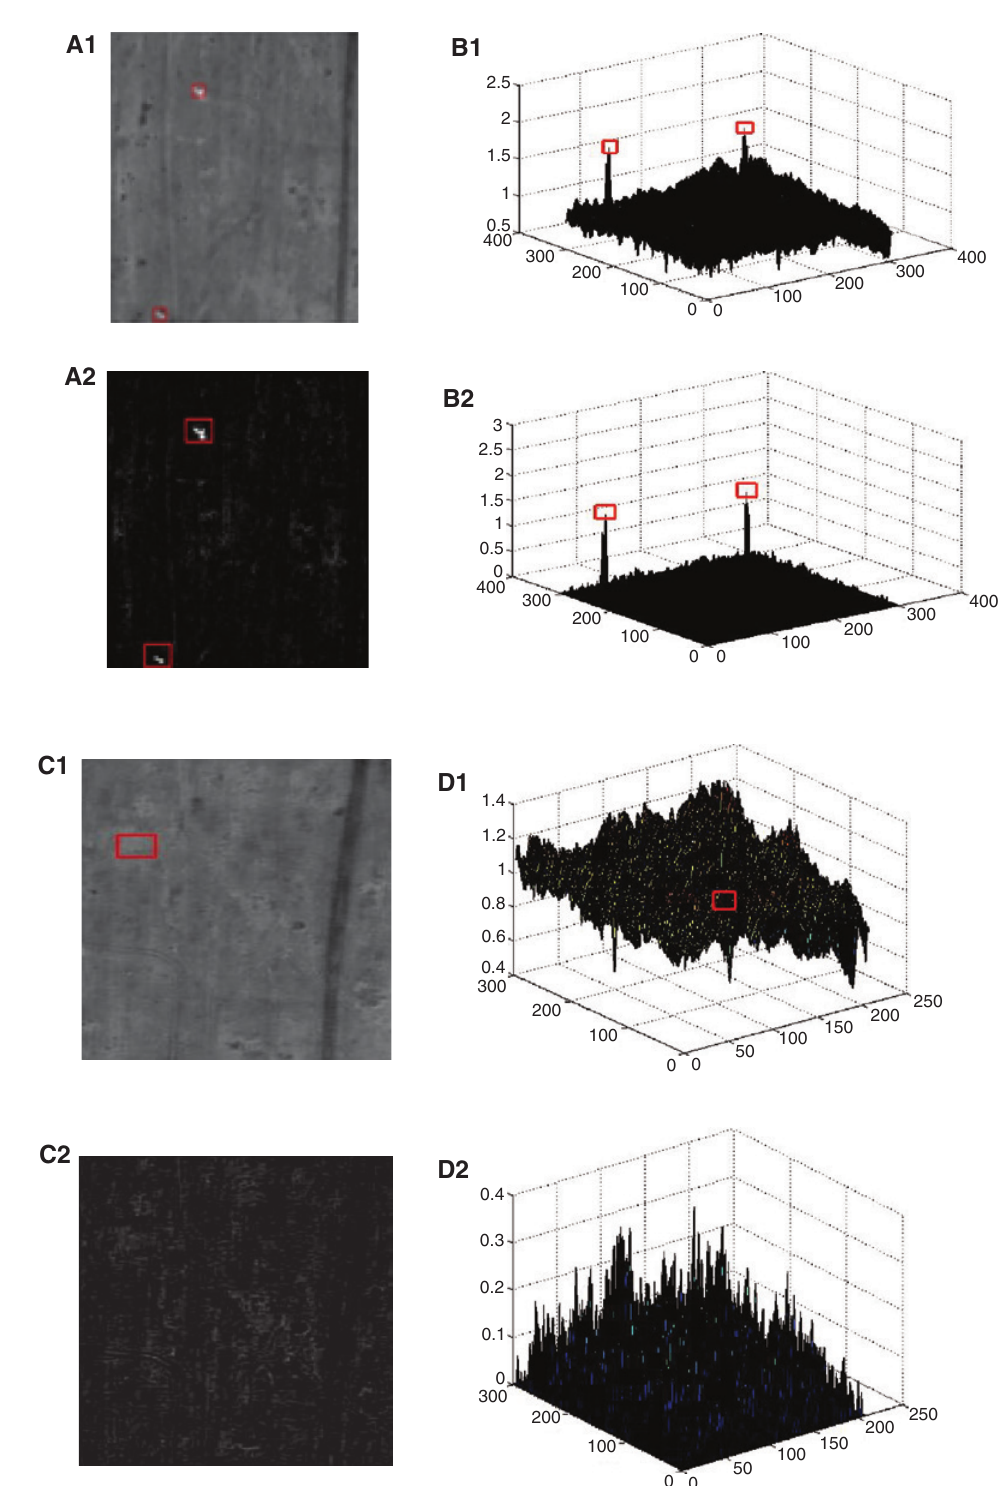
Figure 3: (A1, C1) Original Image with Possible Targets. (A2, C2) Pre-Processed Image. (B1, B2, D1, D2) 3D Plot of Both Unpro- cessed and Pre-Processed